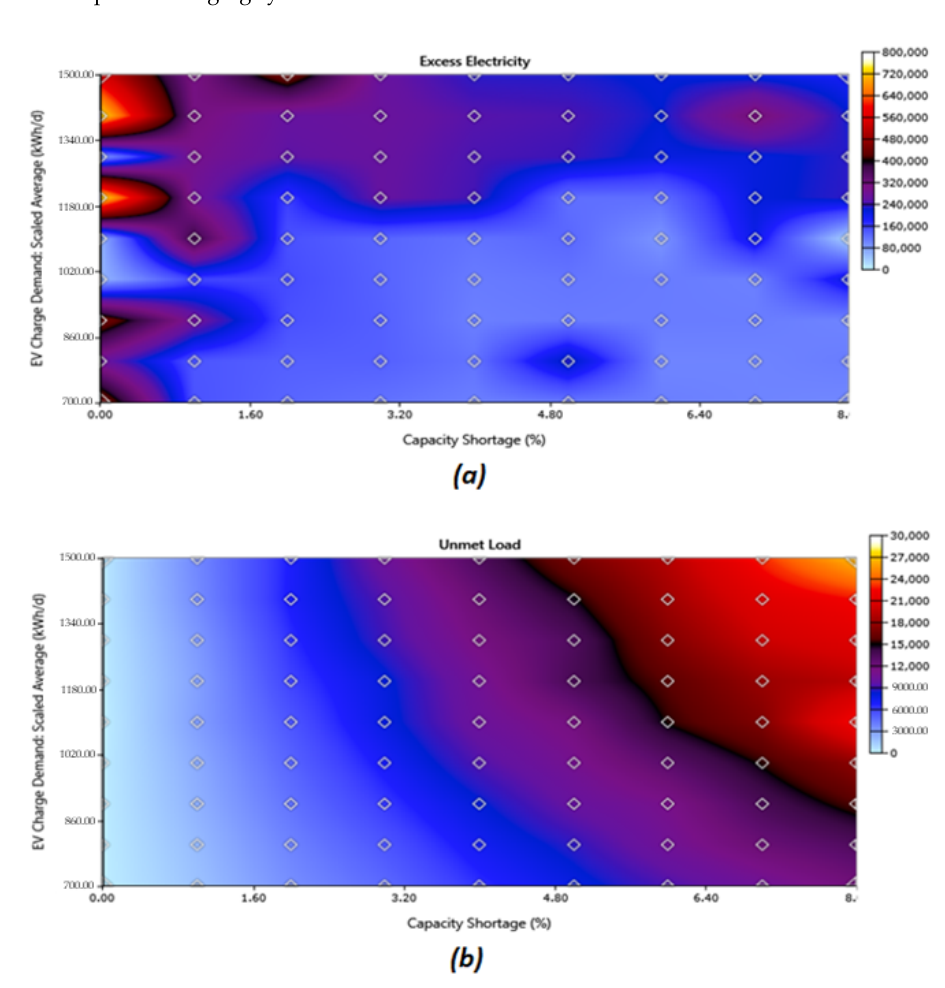
Figure 17. The effect of varying the battery SOC minimum percent value on the technical performance of the optimal charging system.